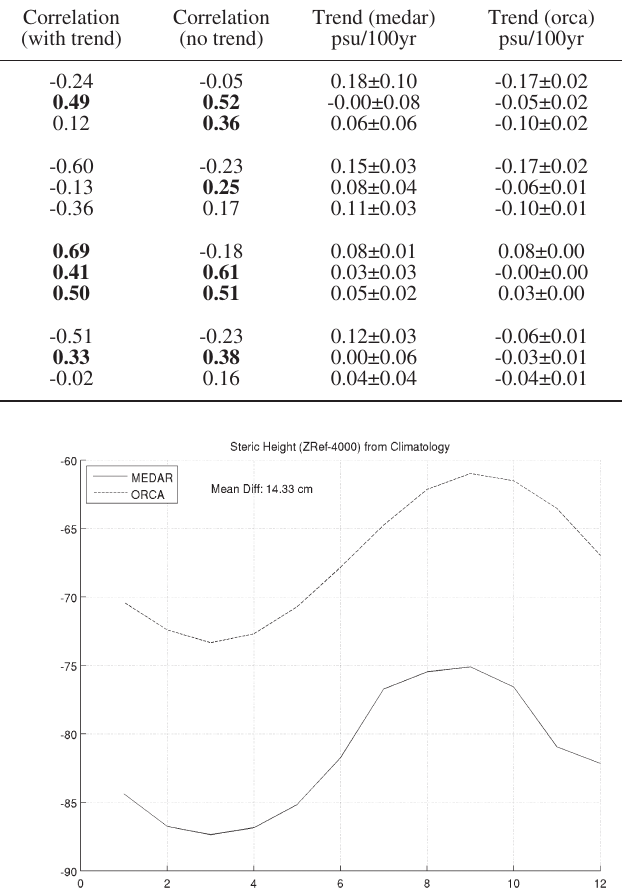
Fig . 4. – ORCA (dashed-line) and MEDAR (solid-line) climatology of steric height calculated from a reference depth level of 4000